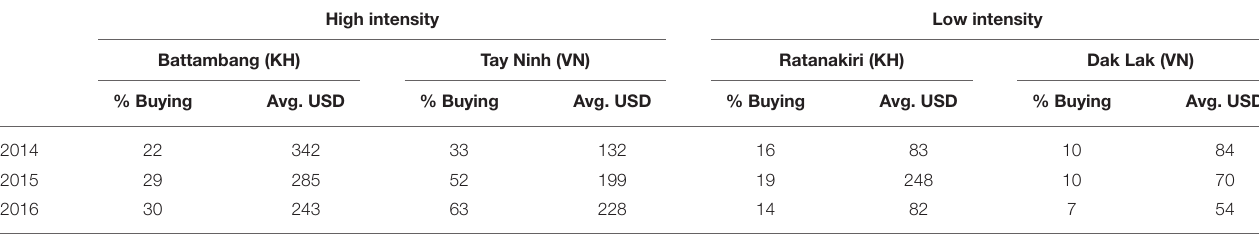
TABLE 3 | Frequency of cassava seed purchase and average total expenditure on seed per household (expressed in USD adjusted to 2017 exchange rates) when cassava seed was purchased in three consecutive seasons at high and low production intensity sites in Cambodia (KH) and Vietnam (VN). High intensity Low intensity Battambang (KH)